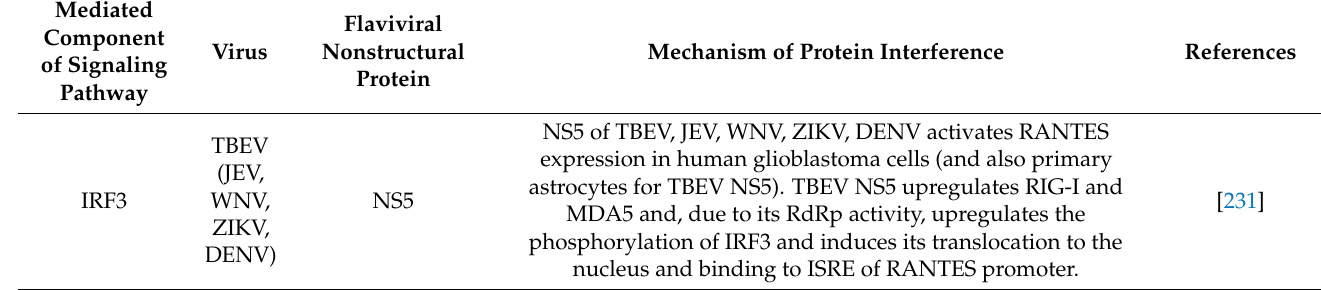
Table 4. Flaviviridae nonstructural proteins’ interference with IFN